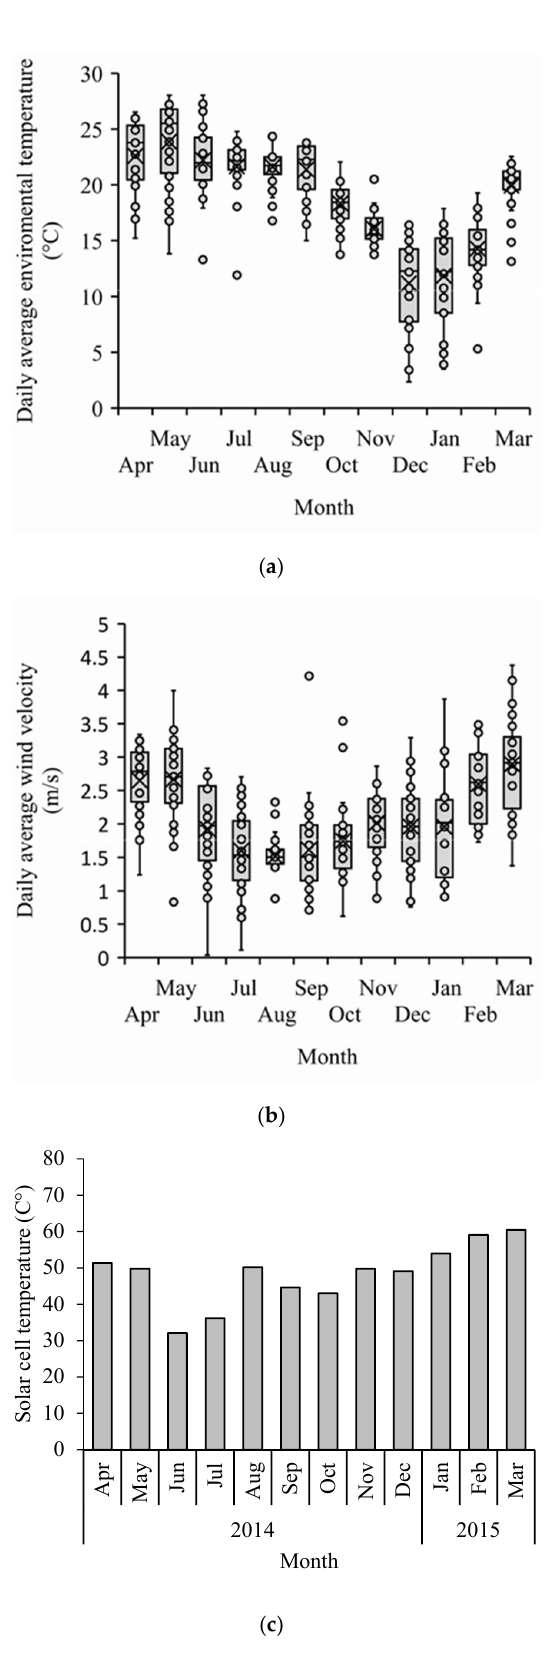
Figure 4. ( a ) Box diagram of daily average environmental temperature during HCPV running time; ( b ) Box diagram of daily averaged wind velocity during HCPV running time; ( c ) Monthly averaged solar cell temperature.